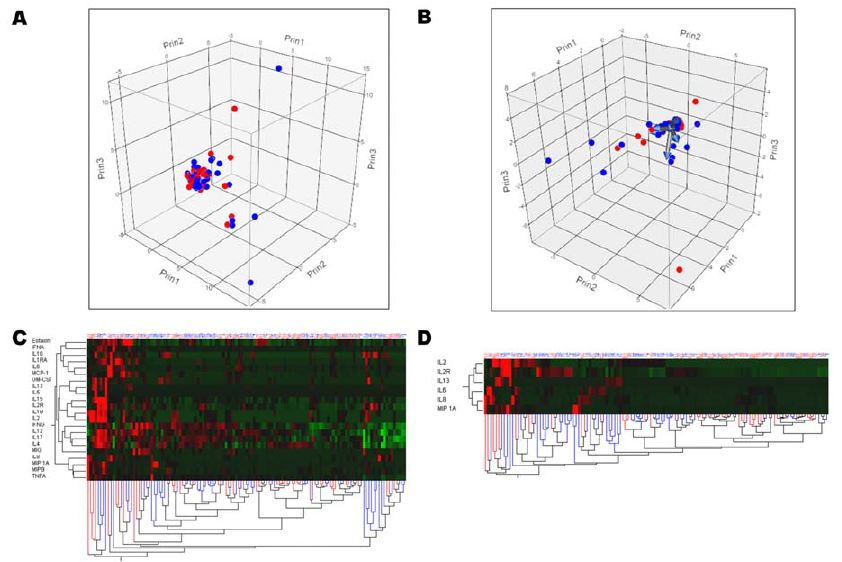
Figure 2. Principal component analysis and clustering of cytokine profiles in patients with (n=55) and without (n=71) severe sepsis. Patients with (red dots) and without (blue dots) severe sepsis are represented according to the first three components computed using principal component analysis of either all 22 cytokines (panel A), or of a limited profile using only IL-13, IL-2, sIL-2R, IL-6, IL-8, MIP-1 a (panel B). Hierarchical cluster analysis using all 22 cytokines measured (panel C) and the more limited profile (panel D) are also presented. The dendrogram at the bottom of panels C & D shows the clustering of patients with (red lines) and without (blues lines) severe sepsis, according to the cytokine profile selected (dendrodram at the left). The color map at the center indicates the cytokine levels for each patient (brightest green is lowest level and brightest red is highest level measured). Altogether, these analyses show patients with severe sepsis cannot be distinguished from those without. doi:10.1371/journal.pone.0028870.g002 Table 4. Serum concentrations of cytokines in patients with and without septic shock.